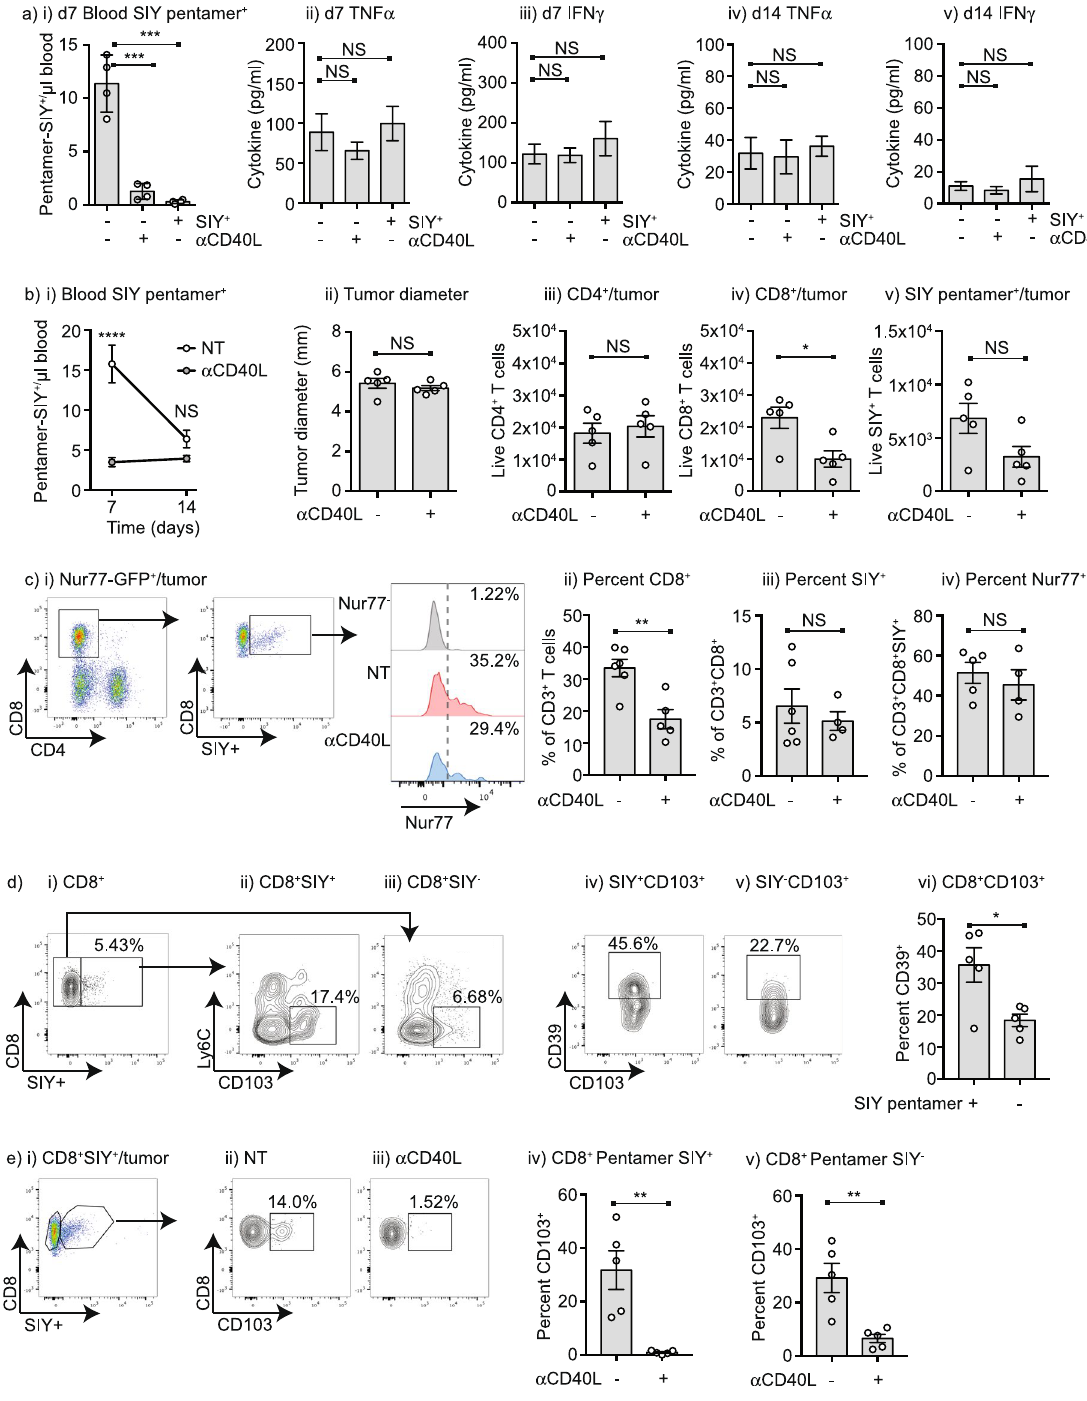
Figure 4. Anti-CD40L at tumor implantation prevents the development of Trm in the tumor environment. ( a ) i) C57BL/6 mice were implanted with Panc02-SIY tumors on d0 and left untreated; implanted with Panc02- SIY tumors and treated with 100 µ g anti-CD40L on d0, d1 and d2; or Panc02-SIY tumors were implanted into SIY + mice that were tolerant to SIY. Graph shows SIY-specific pentamer binding cells in the peripheral blood 7d following tumor implantation. Tumors were harvested on ii-iii) d7 or iv-v) d14 following implantation and analyzed for tumor cytokines by multiplex bead assay. Graphs show levels of TNF α or IFN γ in the tumors. ( b ) C57BL/6 mice were implanted with Panc02-SIY tumors on d0 and left untreated or treated with 100 µ g anti- CD40L on d0, d1 and d2. i) Mice were analyzed for SIY-specific cells in the peripheral blood on d7 and d14 following tumor challenge. ii) Tumor size at d14 following challenge. d14 tumors were harvested and analyzed for the number of tumor infiltrating iii) CD4 + T cells, iv) CD8 + T cells, v) SIY-specific T cells. ( c ) C57BL/6 Nur77-GFP − mice or Nur77-GFP + mice were implanted with Panc02-SIY tumors on d0 and left untreated or treated with 100 µ g anti-CD40L on d0, d1 and d2. i) CD8 + SIY pentamer + T cells were analyzed for